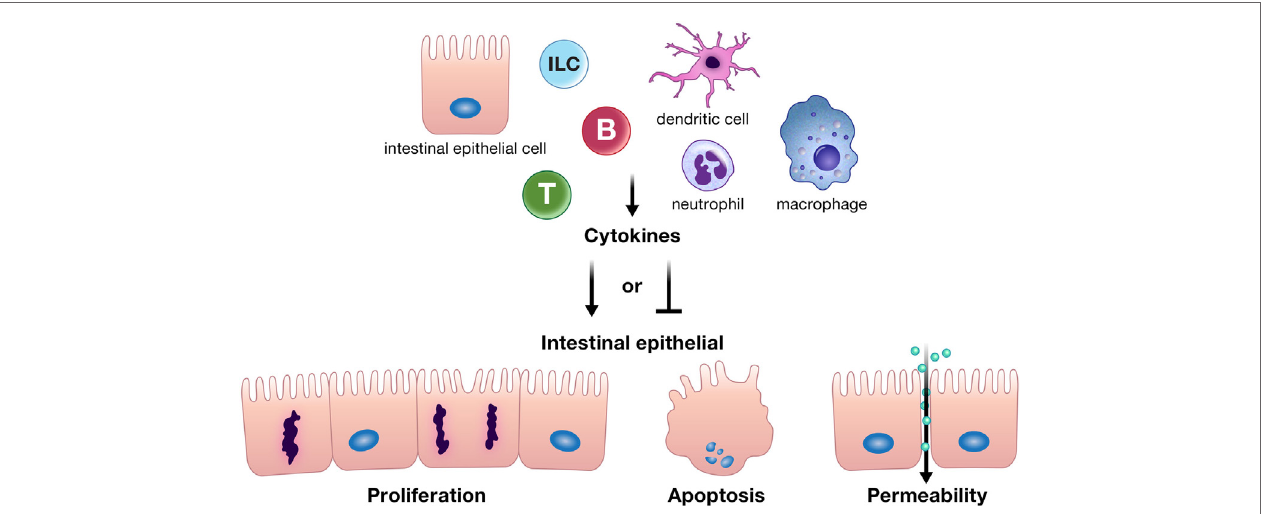
FiGURe 1 | Cytokines can positively or negatively affect intestinal epithelial barrier integrity by driving or inhibiting critical epithelial cell functions such as proliferation, apoptosis, and appropriate epithelial barrier permeability. These cytokines can be derived from resident innate or adaptive immune cells, infiltrating inflammatory cells, or from intestinal epithelial cells themselves. Abbreviations: T, T cell; B, B cell; ILC, innate lymphoid